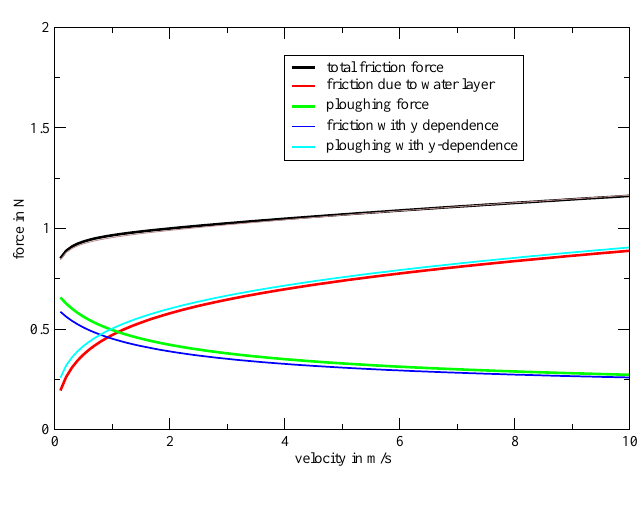
Figure 5: The various contribution to the friction as function of the velocity V , for otherwise skating